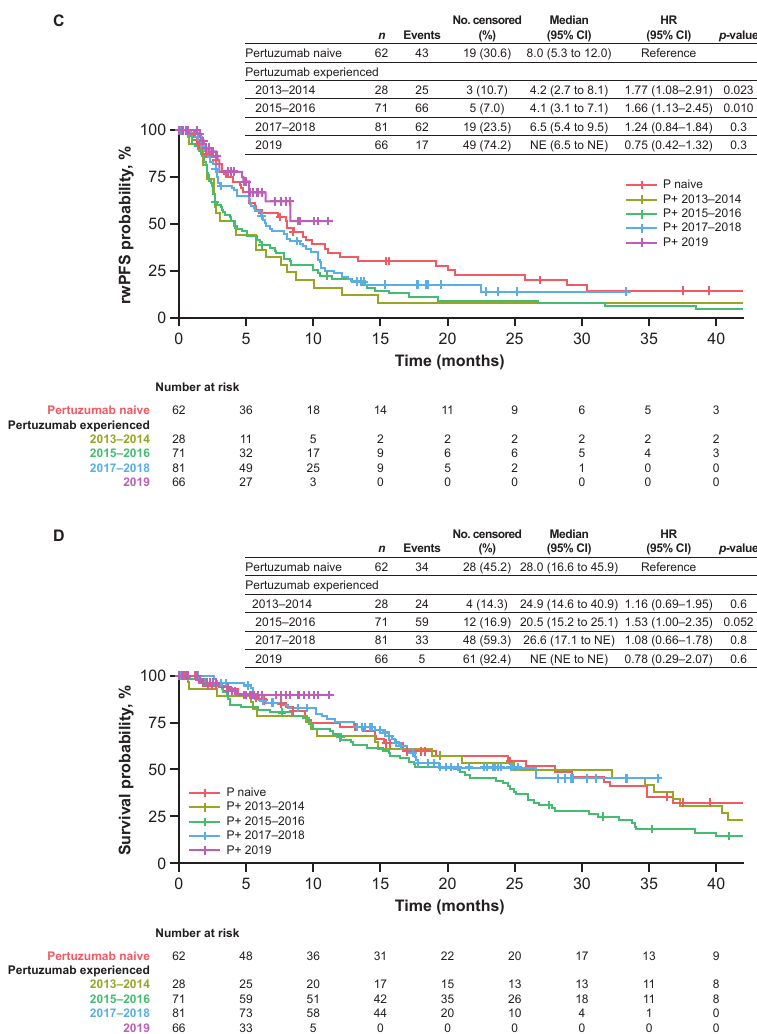
Figure 4. Effectiveness of T-DM1 in the secondary cohort. ( A ) TTNT or death; ( B ) TTLA of T-DM1 before dis-continuation or death; ( C ) rwPFS; and ( D ) OS. The secondary cohort consisted of patients who initiated T-DM1 in the second-line setting following treatment with trastuzumab ± pertuzumab. CI = confidence interval; NE = not estimable; No = number; OS = overall survival; P = pertuzumab; P+ = pertuzumab-exposed; rwPFS = real-world progression-free survival; T-DM1 = trastuzumab emtansine; TTLA = time to last administration; TTNT = time to next relevant